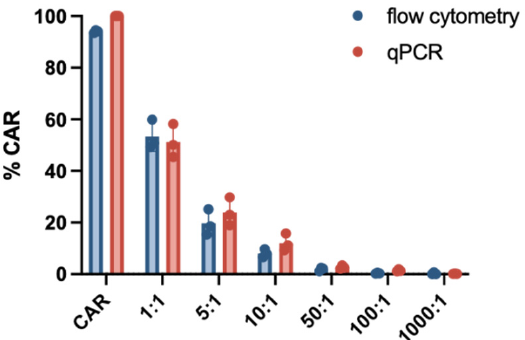
Figure 5. Comparison of CAR-T cell detection using flow cytometry and qPCR. CD19.CAR-T cells were diluted at six different dilutions (1:1 to 1:1000) and the percentage was compared with either flow cytometry using the CD19 CAR detection reagent or qPCR. Experiments were performed using three different HDs and yielded similar results. The graph displays the mean values and standard deviation.